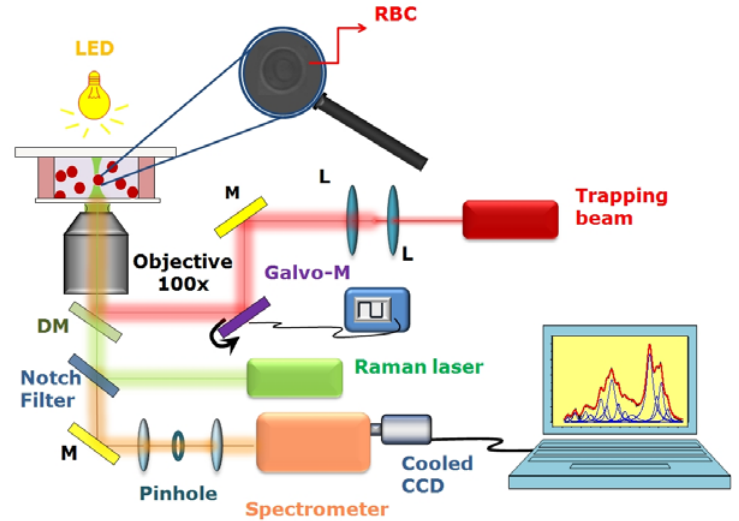
Figure 1. Schematic of our Raman Tweezers system. A Nd:YAG laser at 1,064 nm is used as trapping beam, and a second laser (frequency-doubled Nd:YVO at 532 nm) is used to through a high numerical aperture objective (100 x). The scattering light from the sample is collected by the same objective and coupled into a spectrometer equipped with a cooled CCD camera. Abbreviation: M-mirror L-lens; DM-dichroic